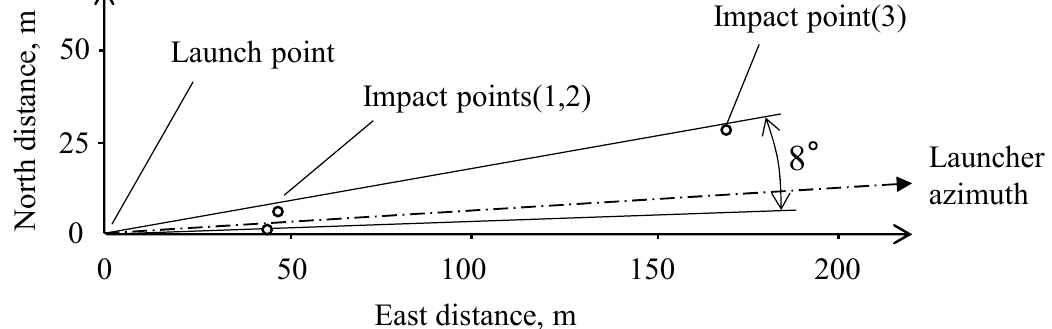
Figure 3. Location of the launch point and impact points.